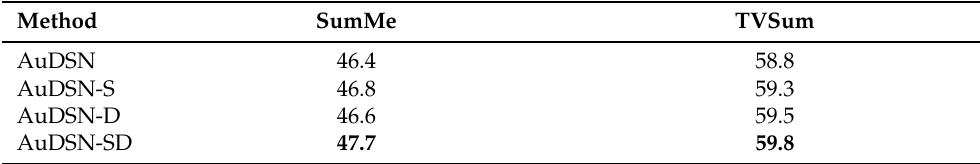
Table 2. Performance (F-scores (%)) of different variants of the proposed method.